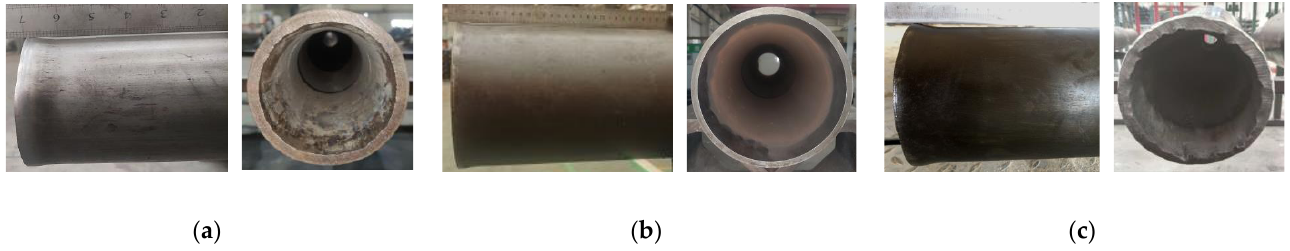
Figure 16. End warping and wrinkling of reduced tube. ( a ) The fourth pass reduced tube with T 0 = 0.4; ( b ) the first pass reduced tube with T 0 = 1.2; ( c ) the fourth pass reduced tube with T 0 = 1.2.